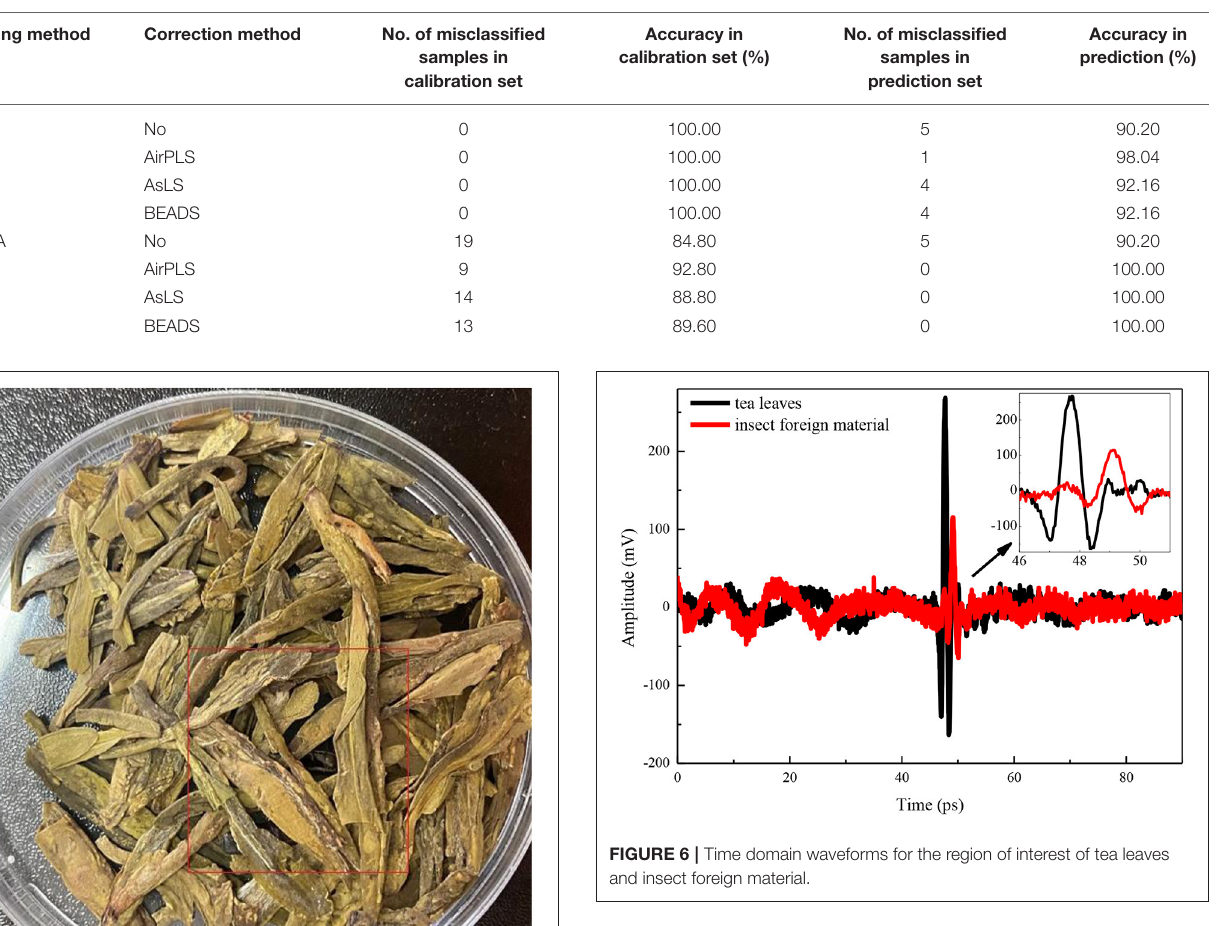
respectively. For models using the same chemometric method,